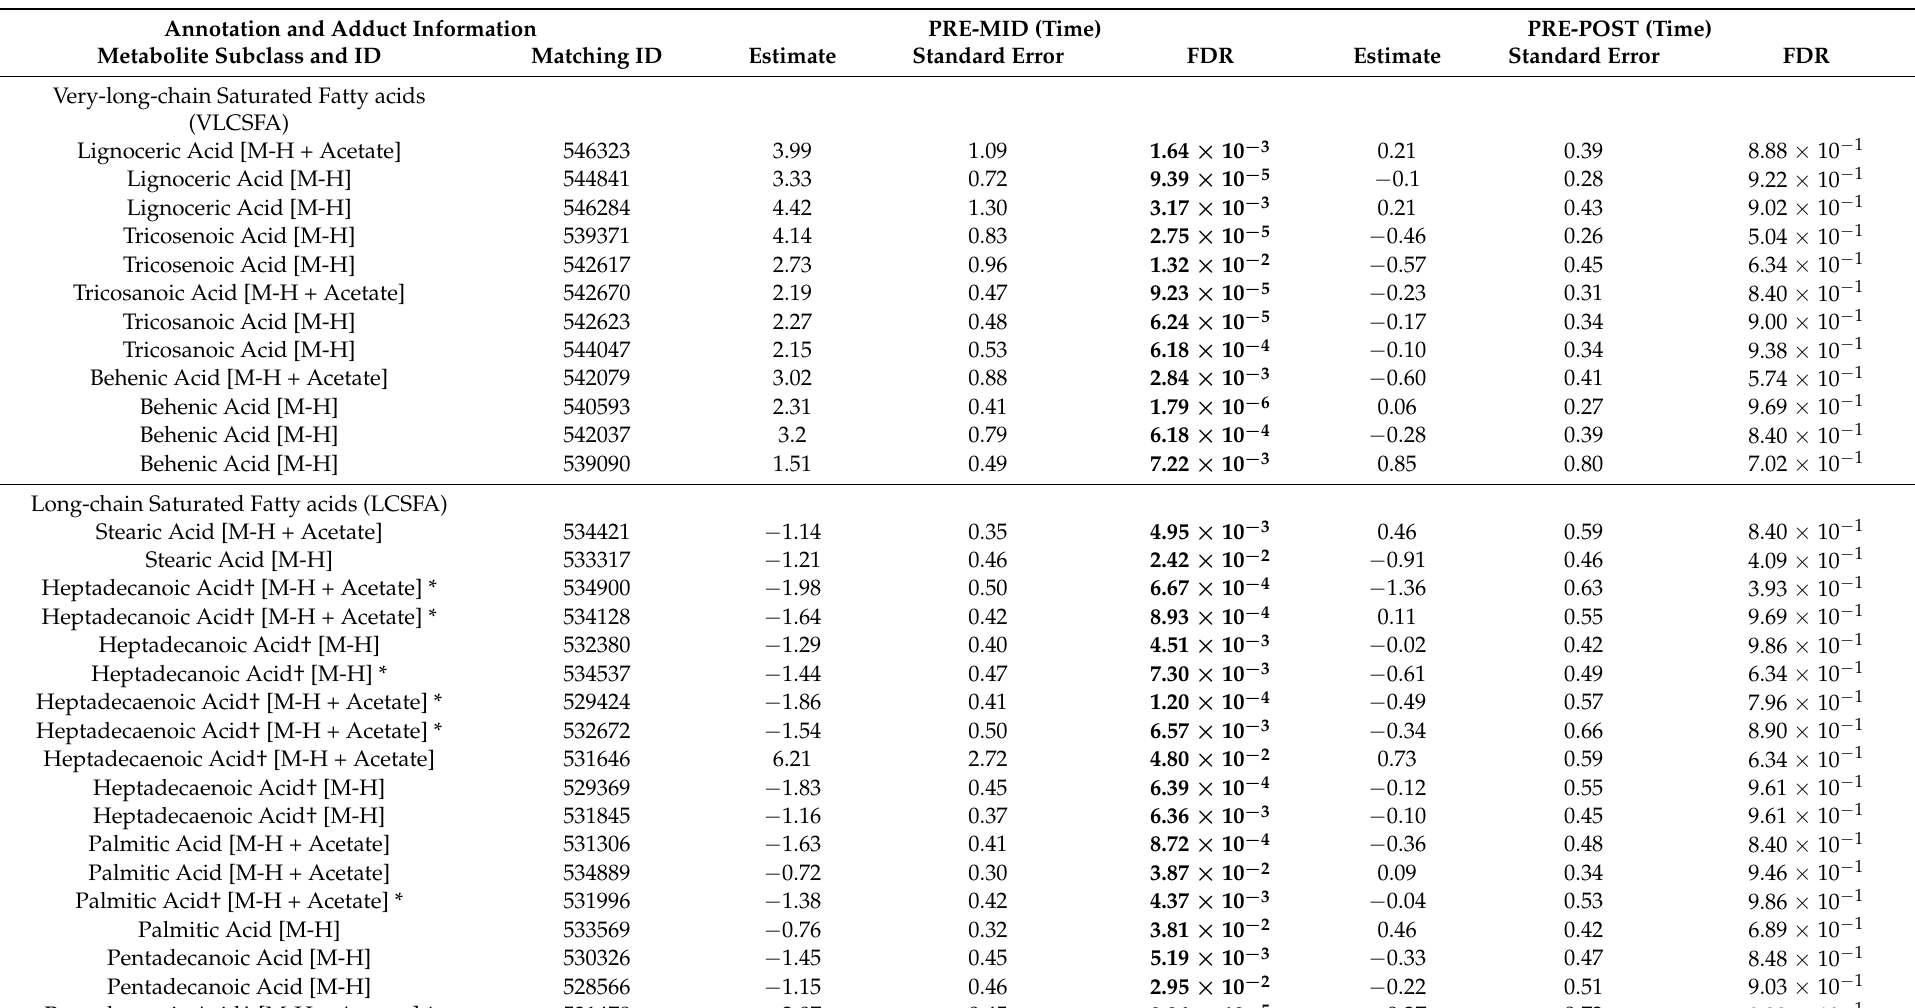
Table 2. The effect of intensive fat mass loss and fat mass regain on free fatty acid (FFA) and oxylipin precursor profile in the diet group of physique study